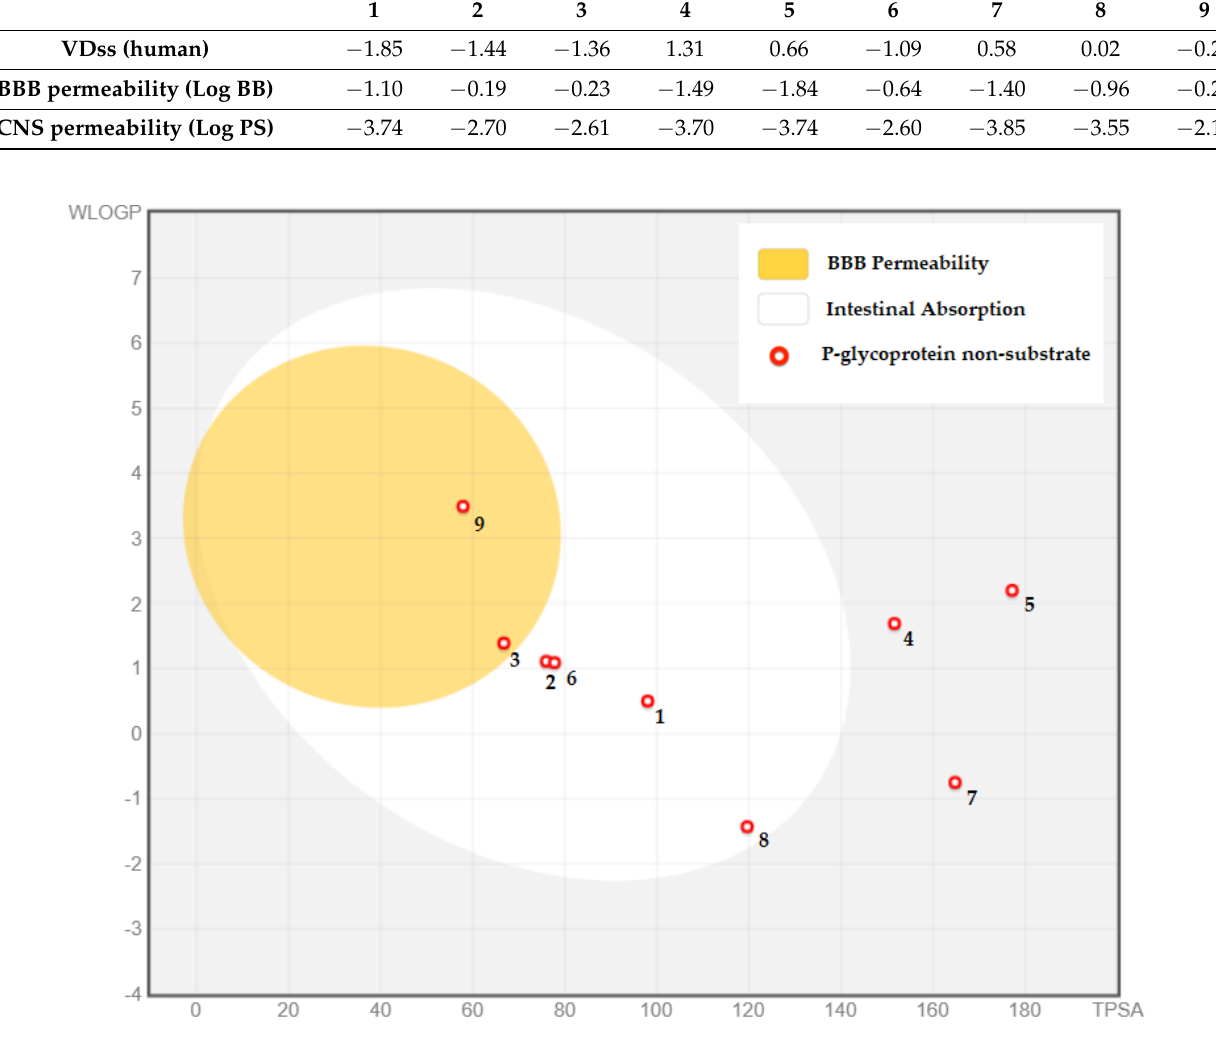
Figure 2. BOILED-Egg method for evaluating blood–brain barrier permeability, gastrointestinal absorption, substrates, and inhibitors of P-glycoprotein for A. halimus leaf chemical composition. ( 1 ) Gallic acid, ( 2 ) syringic acid, ( 3 ) trans -ferulic acid, ( 4 ) myricetin, ( 5 ) catechin gallate, ( 6 ) caffeic acid, ( 7 ) chlorogenic acid, ( 8 ) arbutin, ( 9 ) trimethoxyflavone. Table 4. Distribution characteristics prediction of A. halimus leaf ethanolic extract. ( 1 ) Gallic acid, ( 2 ) syringic acid, ( 3 ) trans -ferulic acid, ( 4 ) myricetin, ( 5 ) catechin gallate, ( 6 ) caffeic acid, ( 7 ) chlorogenic acid, ( 8 ) arbutin, ( 9 ) trimethoxyflavone.